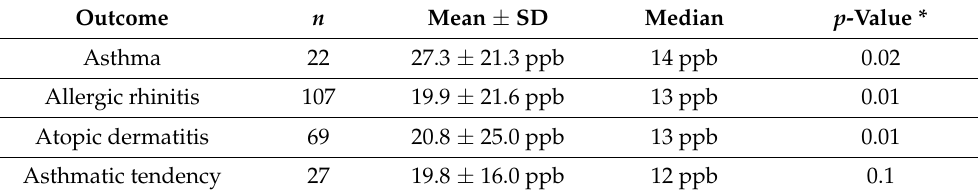
Table 1. Mean values of FeNO according to the respiratory/allergic